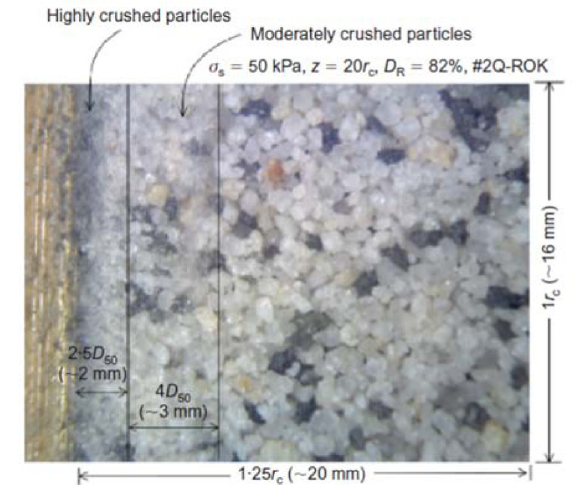
Fig. 11. Microscopic image of pile-soil interface of a model cone in uniform sand (Arshad et al .